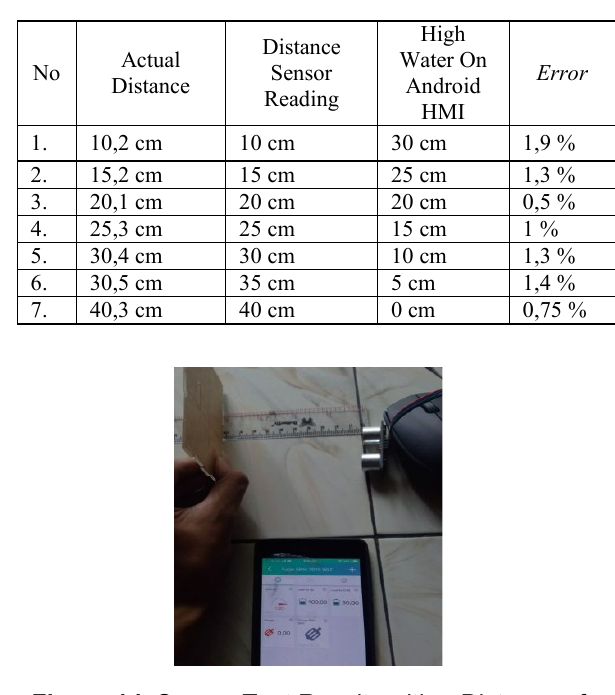
Figure 14. Sensor Test Results with a Distance of